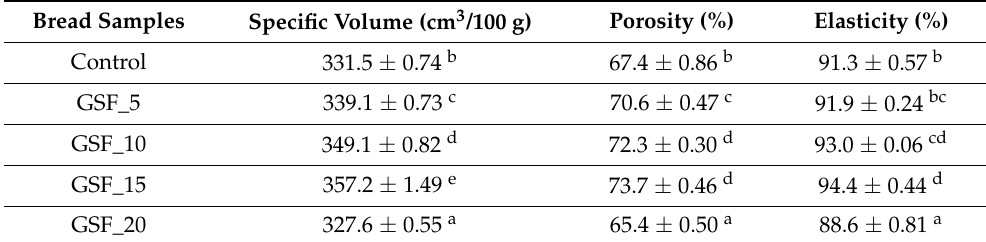
Table 3. Physical characteristics of the bread with different proportions of GSF supplementation in wheat flour.